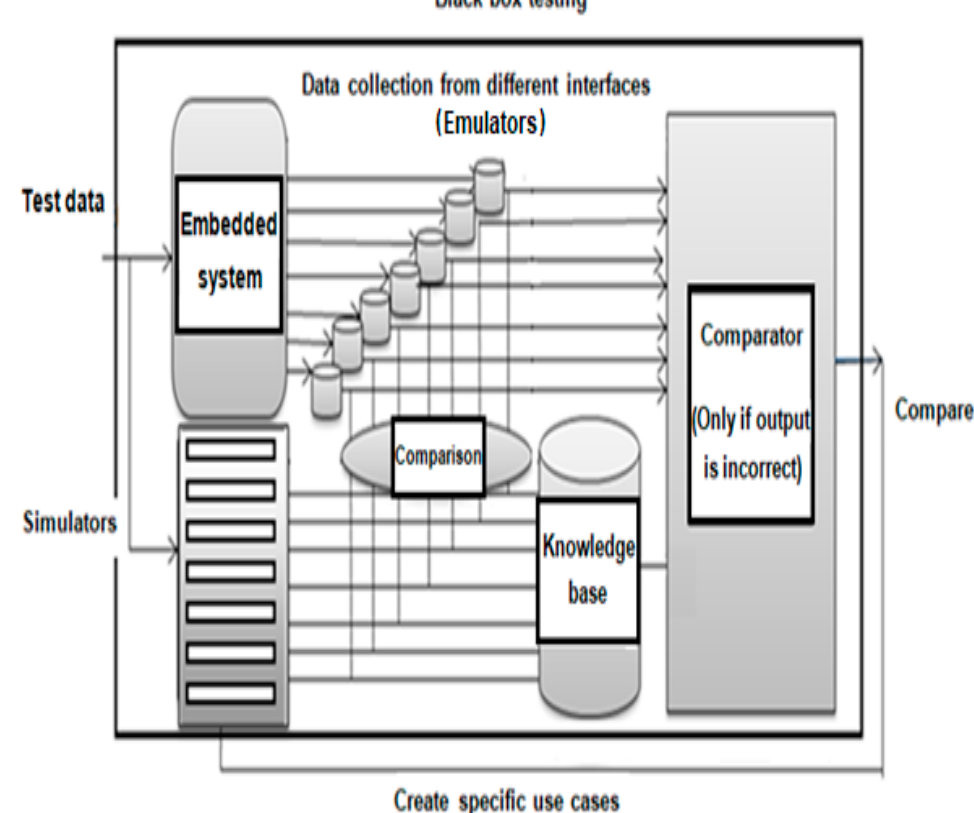
Figure 1. Framework uses multiple instances of simulators with physical interfaces to emulate real-time embedded system.